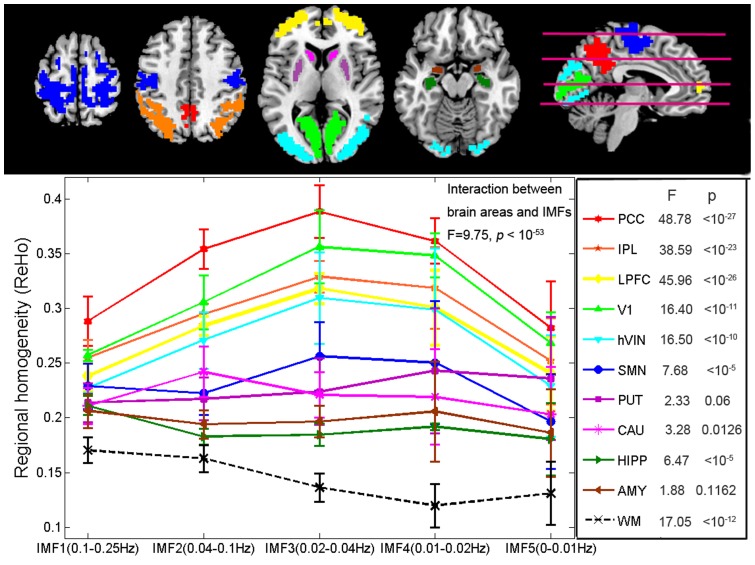
Frequency-specific ReHo in different brain regions.Upper panel: The conjunction masks created from the clustering results. Lower left panel: The ReHo values were averaged across all the voxels within each of the brain regions/networks for each subject. Group mean and standard errors (SE) of ReHo for each IMF were then determined across the 198 subjects. Lower right panel: F-scores and corresponding P values from the balanced one-way ANOVA performed for each of the brain regions/networks. Abbreviations: posterior cingulate cortex (PCC)/precuneus, bilateral inferior parietal lobule (IPL), lateral prefrontal cortex (LPFC), primary visual area (V1), higher-order visual network (hVIN), sensory motor network (SMN), putamen (PUT), caudate (CAU), hippocampus (HIPP), amygdala (AMY) and white matter (WM).